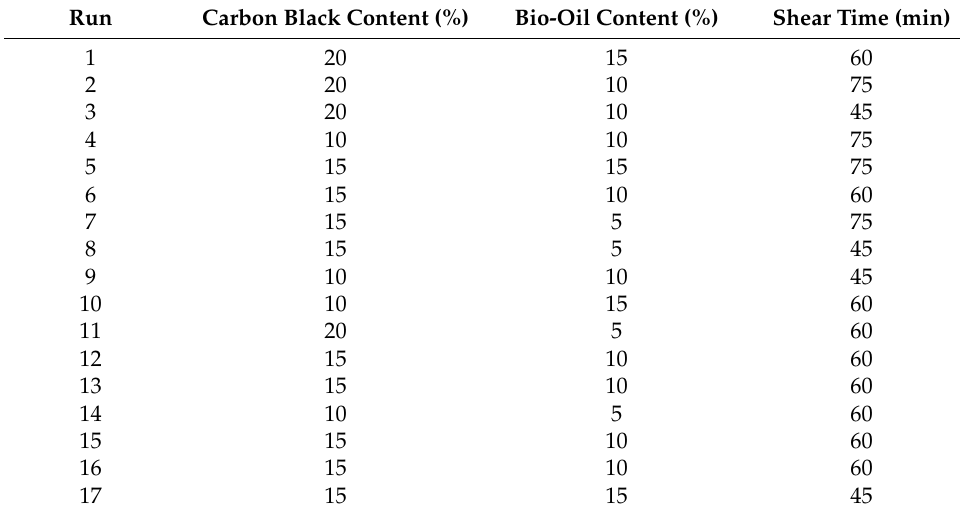
Table 4. Experimental design based on BBD